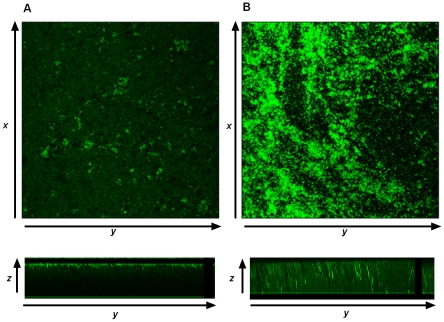
Visualization of homotypic biofilm formation by P. gingivalis grown in GAM or CSE.48 hr P. gingivalis biofilms, formed in an open flow system, were stained with FITC. Optical sections were obtained along the x-y and z axis at 1 µm intervals. (A) and (B) are representative images of biofilms formed in GAM or GAM-CSE, respectively. Top panels represent x-y images while the bottom panel shows x-z stacks, reflecting biofilm thickness formed in GAM or GAM-CSE, respectively. Z-stack images were obtained from 5 randomly selected fields per biofilm and image data recorded along the x-y-z planes.